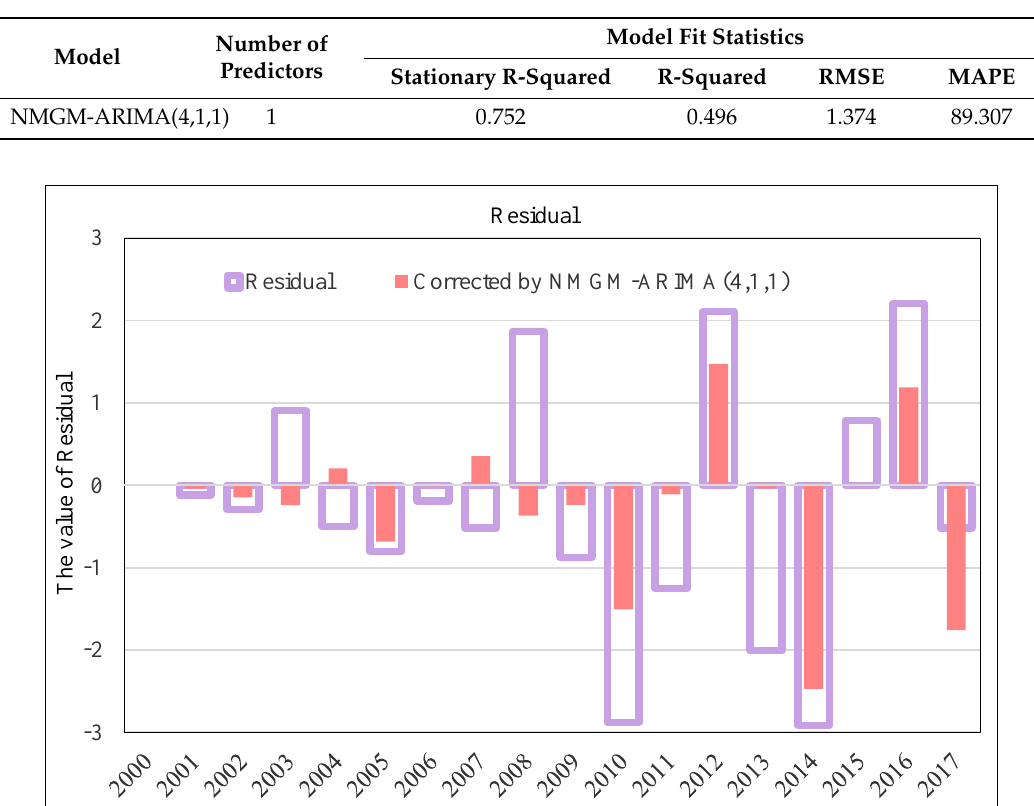
Figure 8. Comparison between the residual of NMGM fitting results and the corrected residual.